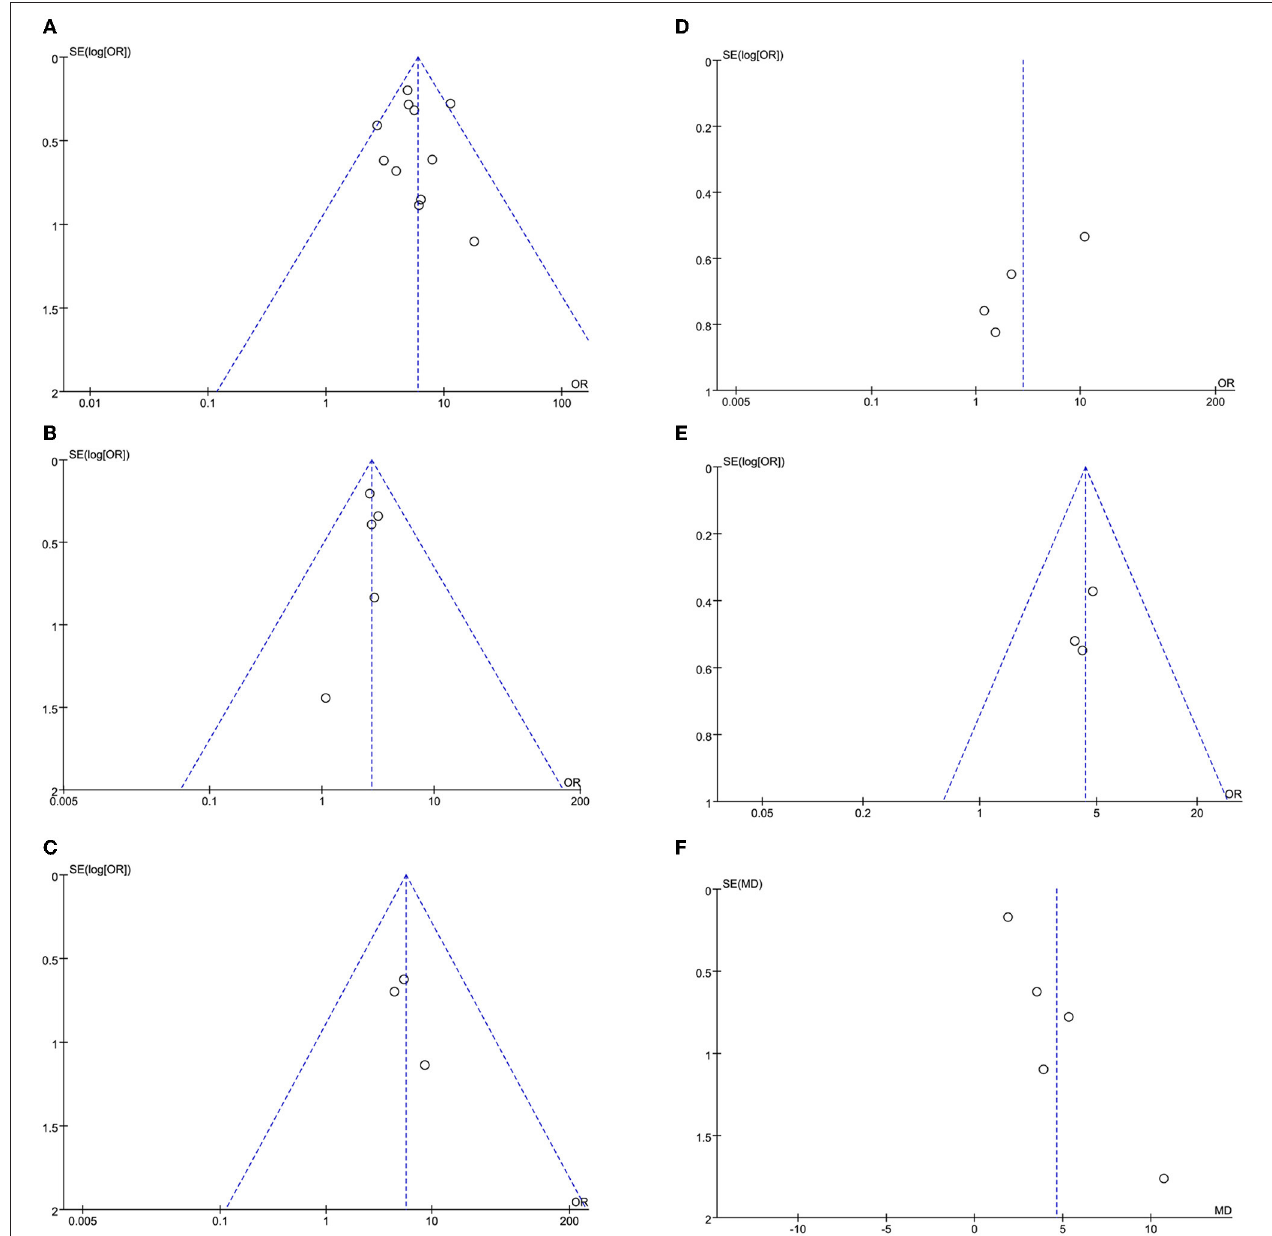
FIGURE 9 | (A) In-hospital mortality funnel plot. (B) Cardiogenic shock funnel plot. (C) Stent thrombosis funnel plot. (D) Bleeding funnel plot. (E) ICU admission rate funnel plot. (F) Length of stay funnel plot.